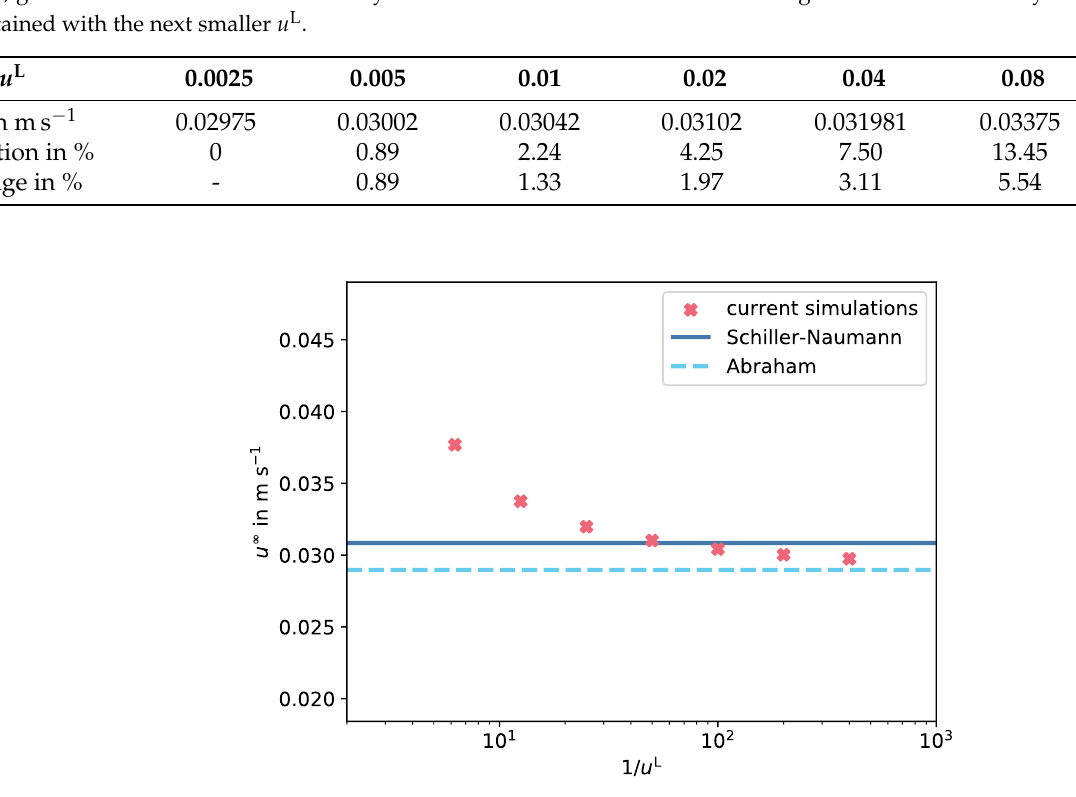
Figure 5. Maximum settling velocity for µ f = 0.005kgm − 1 s − 1 over the chosen lattice velocity u L (see Equation (27)).